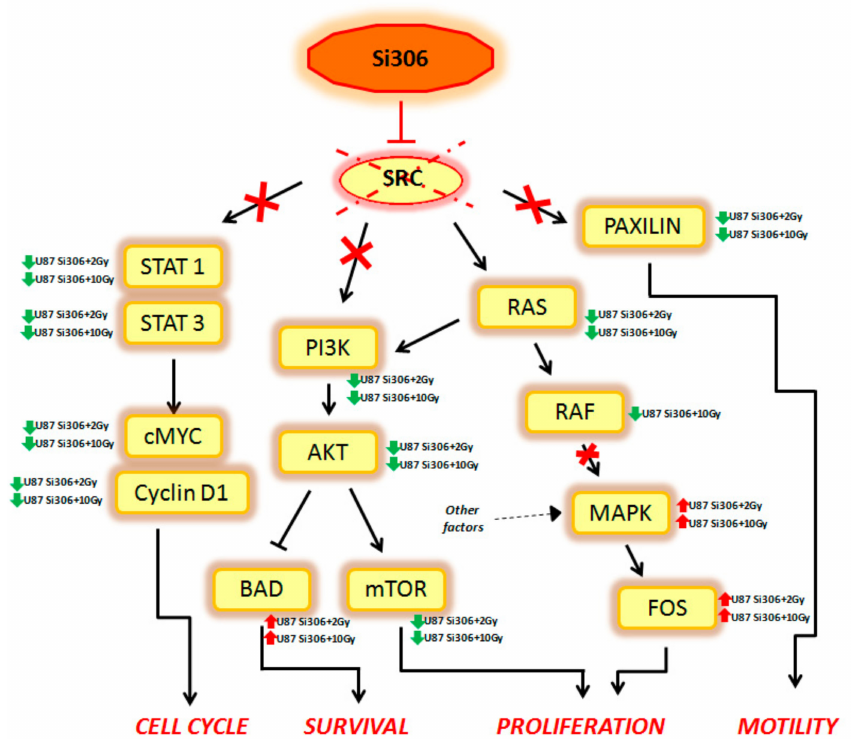
Figure 3. The figure displays the main targets of Si306 compound observed. The arrows define an activation and the T bars the inhibition. Red arrows define gene upregulation and green arrows gene